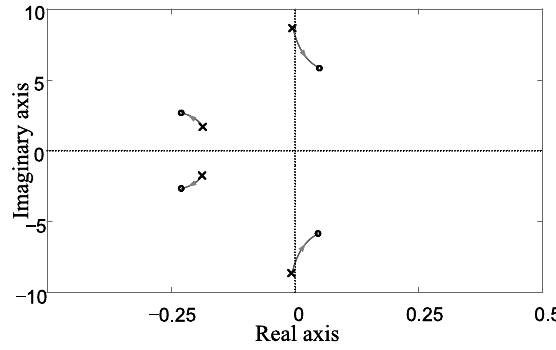
Figure 11. The bus voltage waveform when m 1 = 2 × 10 − 5 Hz/W and m 2 = 10 × 10 − 5 Hz/W. (3) When m 2 = 2.5 × 10 − 5 Hz/W, the root locus equation whose gain is m 1 is ( ) + 1= 0 mW s . (23) 1 3 The root locus of D ( s ) when m 1 varies from 0 to +∞ is shown in Figure 12.